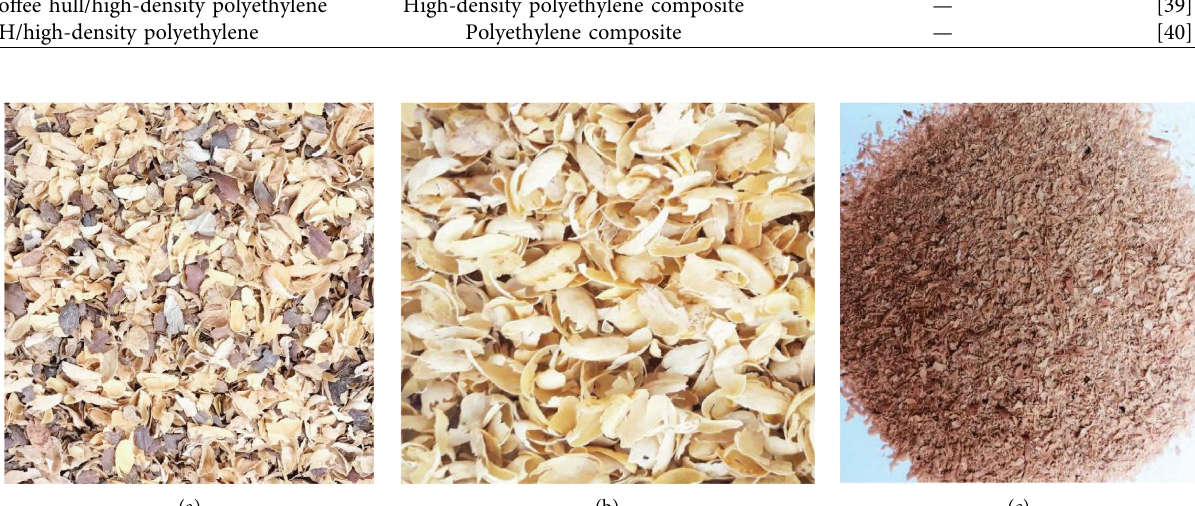
Figure 1: (a) Waste cofee husk. (b) Outer skin isolated waste cofee husk (cofee pulp and parchment). (c) Ground outer skin isolated cofee